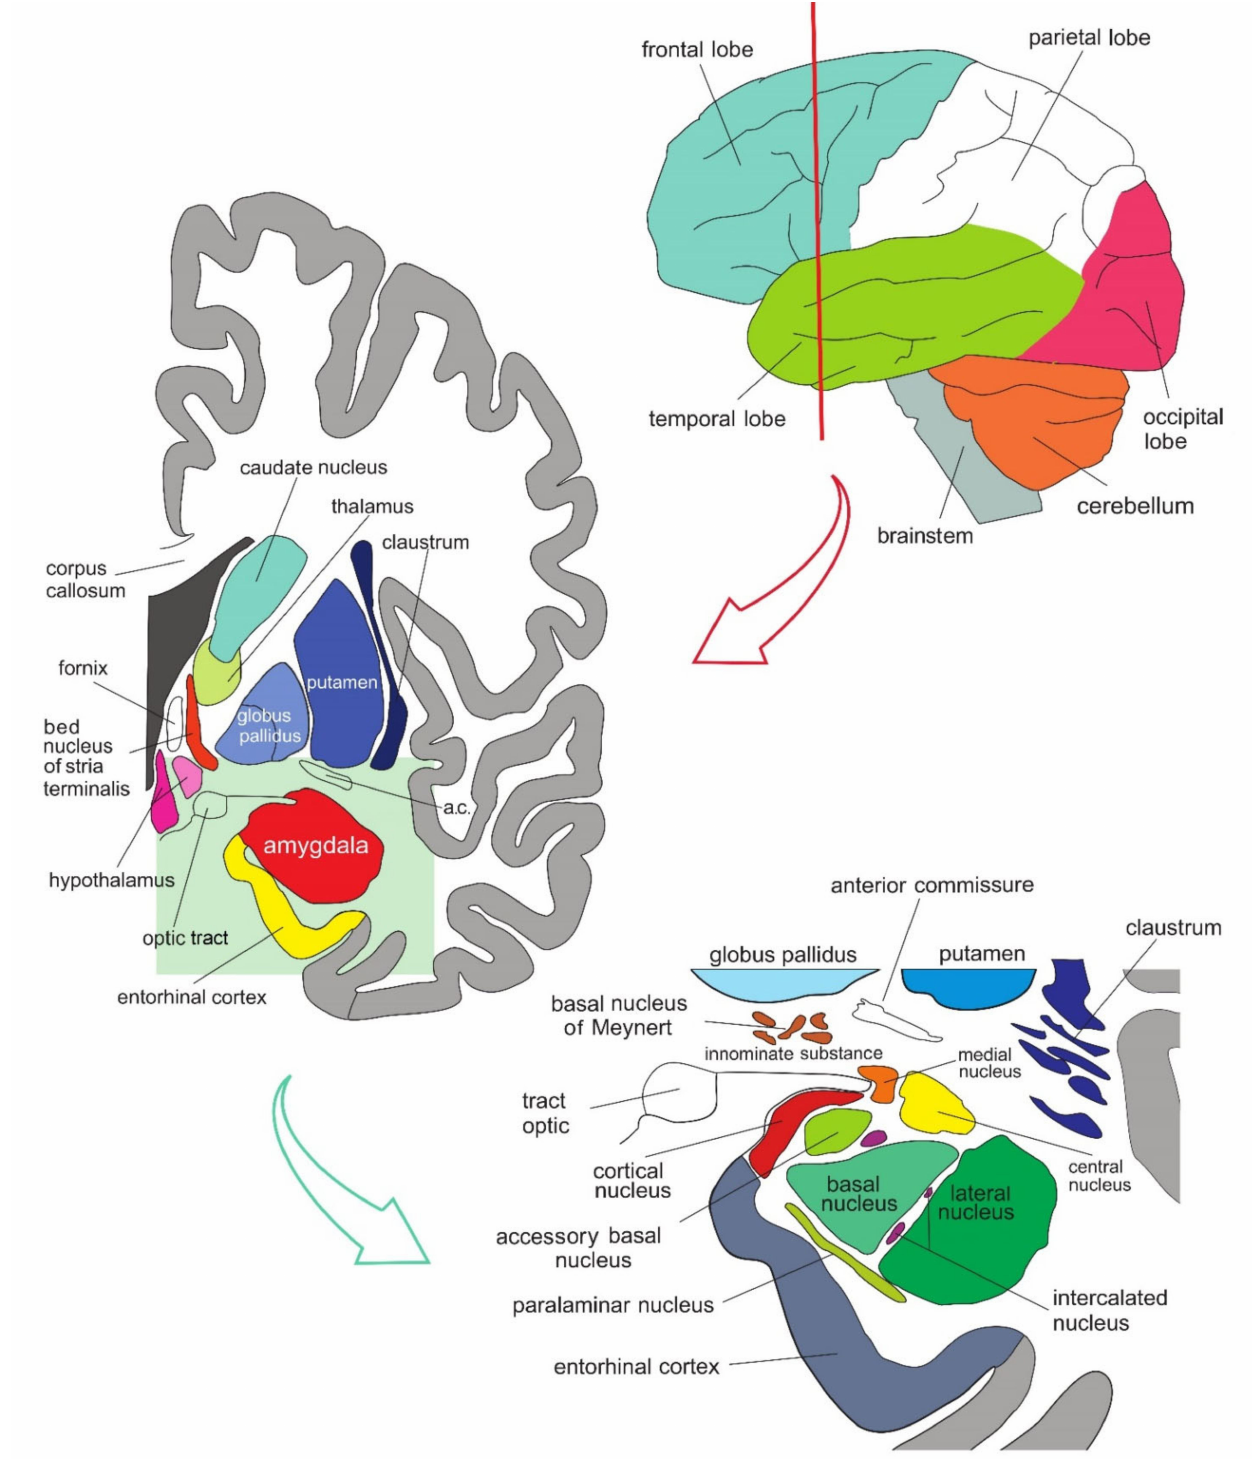
Figure 5. Simplified representation of the structure and location of the amygdala. The upper part of the schematic shows the human brain when viewed from the lateral side, where the brainstem, cerebellum, and four lobes of the cerebrum can be seen. The middle part of the schematic shows the structures present on the coronal plane through the temporal lobe of the cerebrum on which the position of the amygdala can be observed. The lower part of the schematic shows an enlarged amygdala with its individual nuclei. a.c.—anterior commissure. See text for